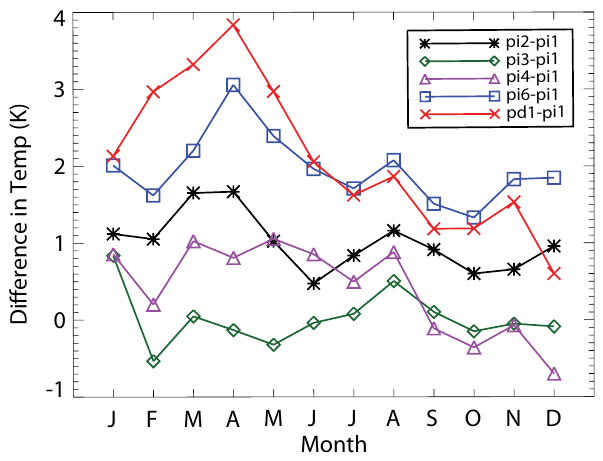
Fig. 9. Monthly surface air temperature differences between (pi2, pi3, pi4, pi6, pd1) and pi1 averaged over Tibetan Plateau (Unit: K).